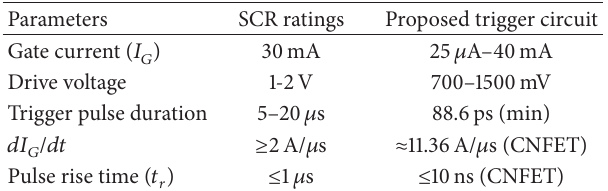
Table 2: Different parameter of SCR and proposed trigger pulse